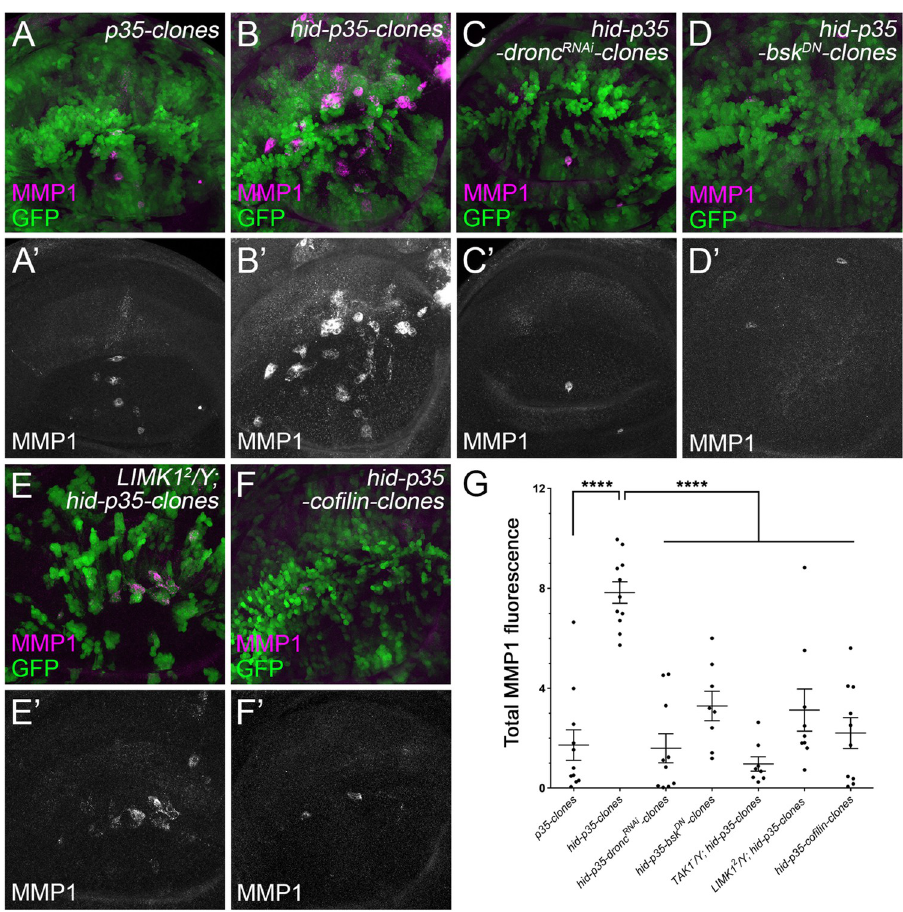
Fig 5. LIMK1 and Cofilin regulate activation of JNK in hid-p35 clones. (A-F’) Late 3 rd instar wing discs with 48-hour old mosaic clones positively marked by GFP. MMP1 (magenta in A-F and grey in A’-F’) is a marker of JNK activity. Images of Z-stack projections are shown as the MMP1 signals localize at the basal part of the disc. A low level of MMP1 signals was detected in the control clones expressing P35 (A, A’). In contrast, a strong increase of MMP1 labelling was observed in the clones simultaneously expressing hid and p35 ( hid-p35 clones) (B, B’). Such a strong level of MMP1 signals is largely inhibited by expression of dronc RNAi (C, C’), bsk DN (D, D’), or in LIMK1 2 mutants (E, E’). Expression of cofilin also suppresses the hid-p35 -induced MMP1 expression (F, F’). (G) Quantification of the MMP1 signal intensity in the representative wing disc pouches carrying clones of the indicated genotypes. Compared to the discs with p35 clones, the MMP1 signals are significantly ( ���� p < 0.0001) increased in the discs with hid-p35 clones. This increase is significantly ( ���� p < 0.0001) reduced in response to expression of dronc RNAi , bsk DN , cofilin or in Tak1 hemizygous null mutants or LIMK1 2